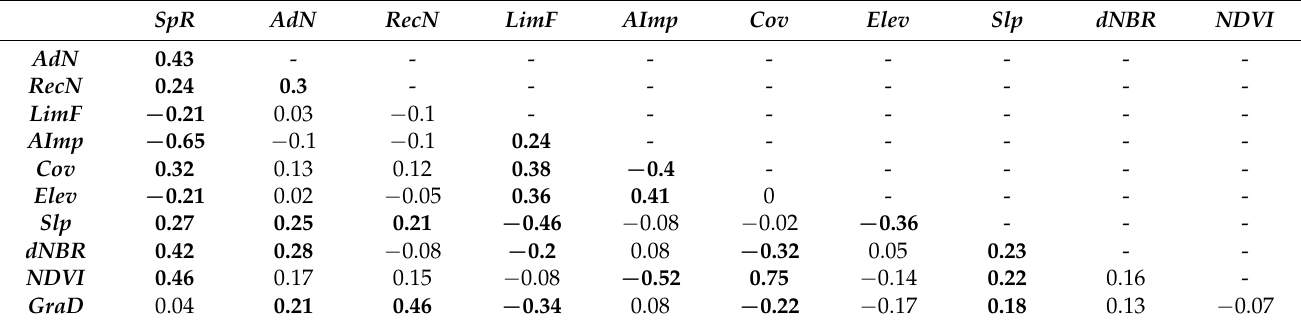
Table 3. Correlation matrix. SpR : focal species richness, AdN : No. of adults and sub-adults, RecN : No. of saplings and juveniles, LimF : limiting factors, AImp : anthropogenic impacts, Cov : tree canopy cover, Elev : elevation in meters above sea level, Slp : slope expressed as degrees, dNBR : differenced